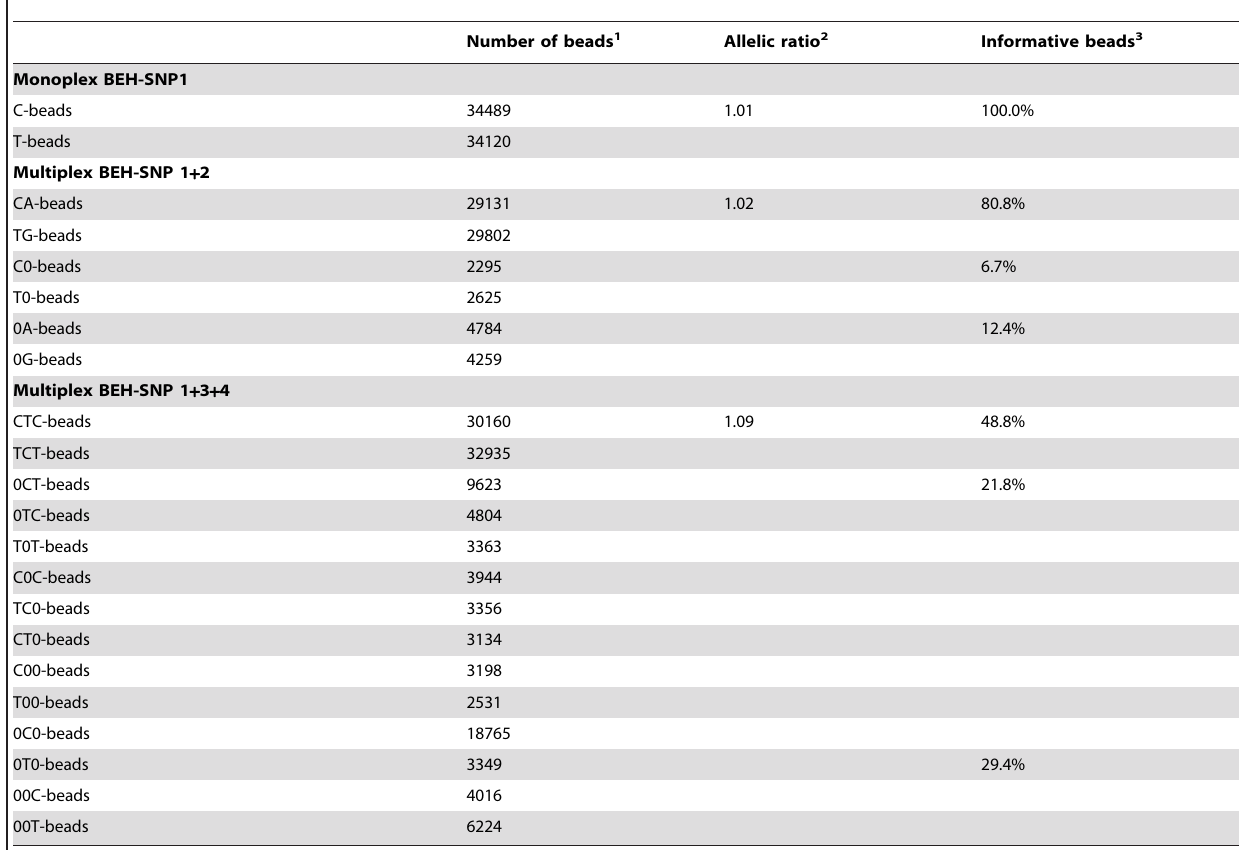
Table 1. Bead-emulsion haplotyping (BEH) targeting 1, 2, or 3 SNP